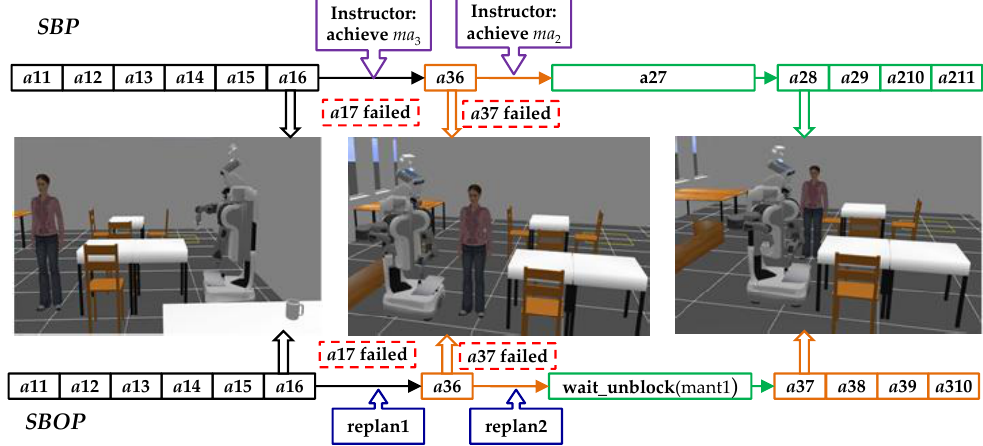
Figure 6. The execution process of the abstract plan based on schema-based planner (SBP) and schema-based optimized planner (SBOP). The purple boxes above the plan are abbreviated intervention instructions from the instructor. Each blue box under the plan is a process of replanning based on partially backtracking.